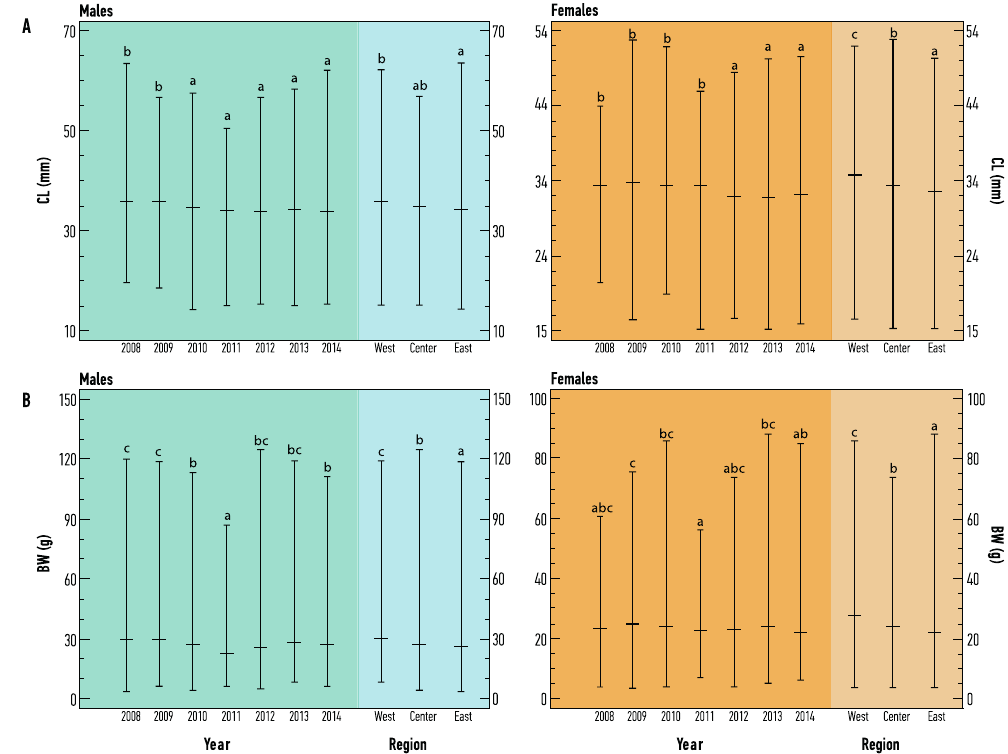
differences at the 95.0% confidence level.